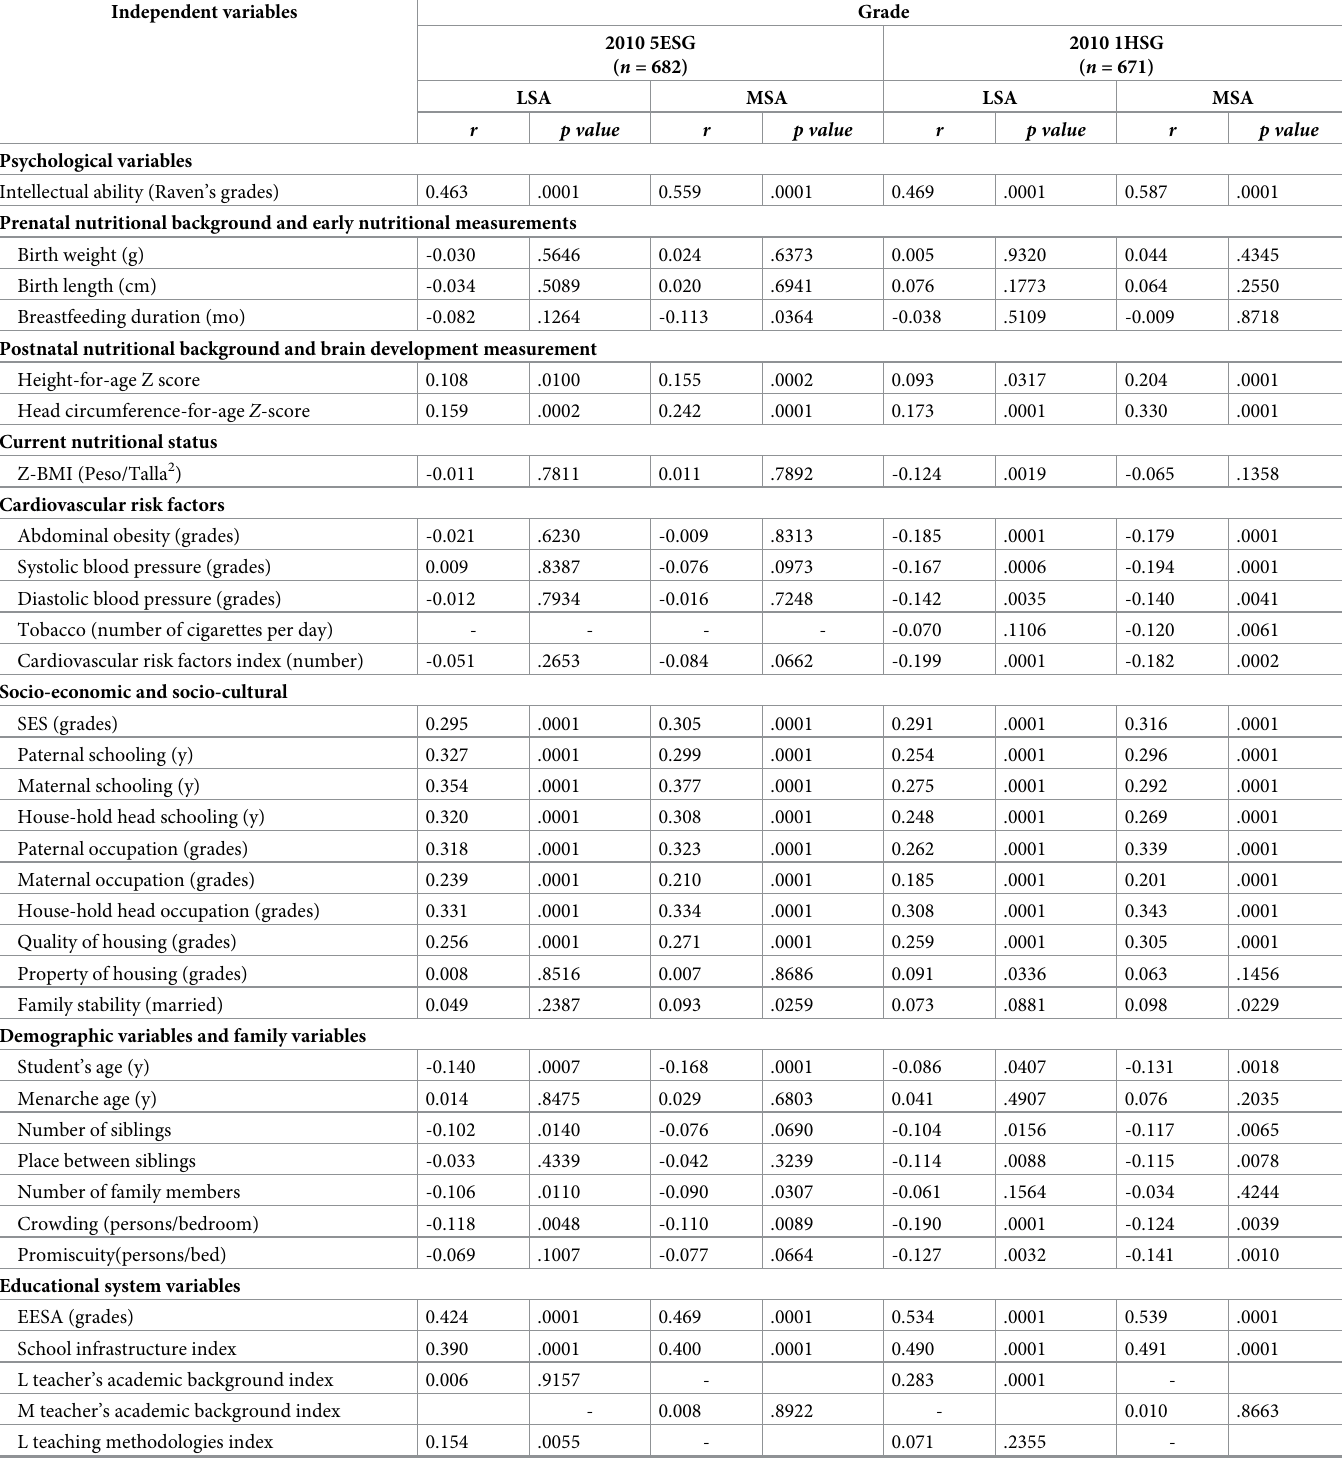
Table 1. Correlation coefficients between scholastic achievement (SA) in the Education Quality Measurement System (2009 SIMCE) tests of language (LSA) and mathematics (MSA) (dependent variables) and psychological, nutritional, cardiovascular risk, socio-economic, socio-cultural, demographic, family, and educational indicators (independent variables) by